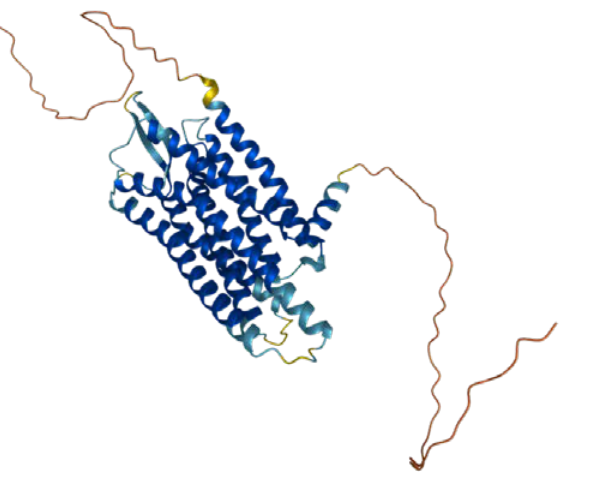
Figure 1. Structure of GRPR with seven transmembrane domains. Reprinted from ref. [13].